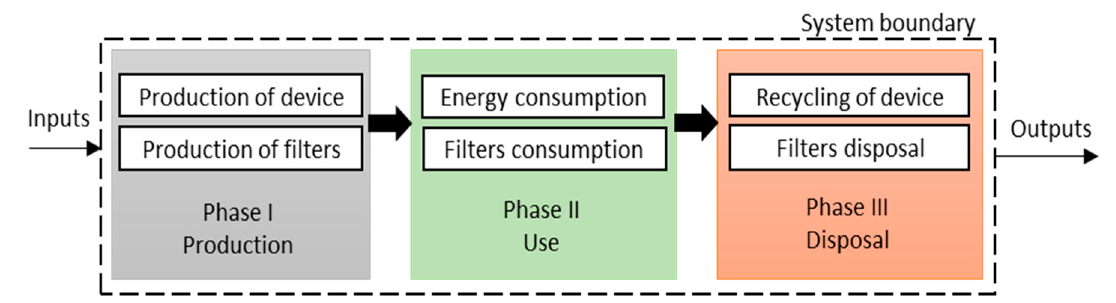
Figure 2. The scheme of life cycle assessment (LCA) phases in the process of air cleaning.